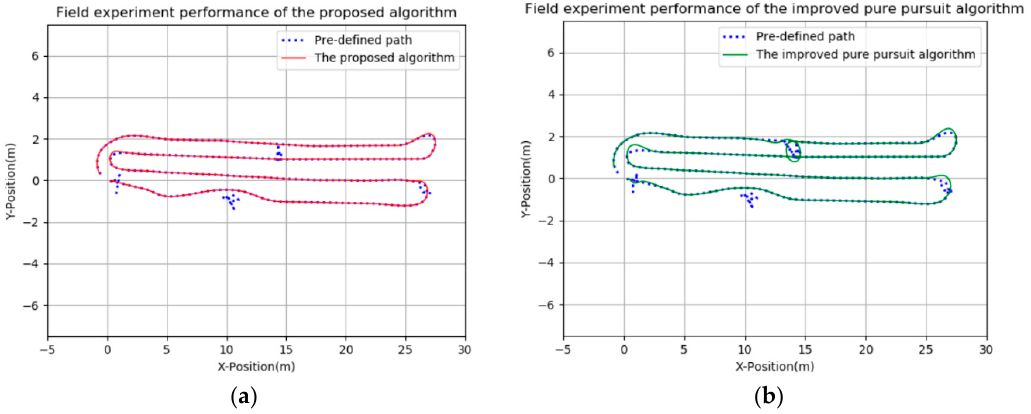
Figure 10. ( a ) Field experiment performance of the proposed algorithm. ( b ) Field experiment performance of the improved pure pursuit algorithm.